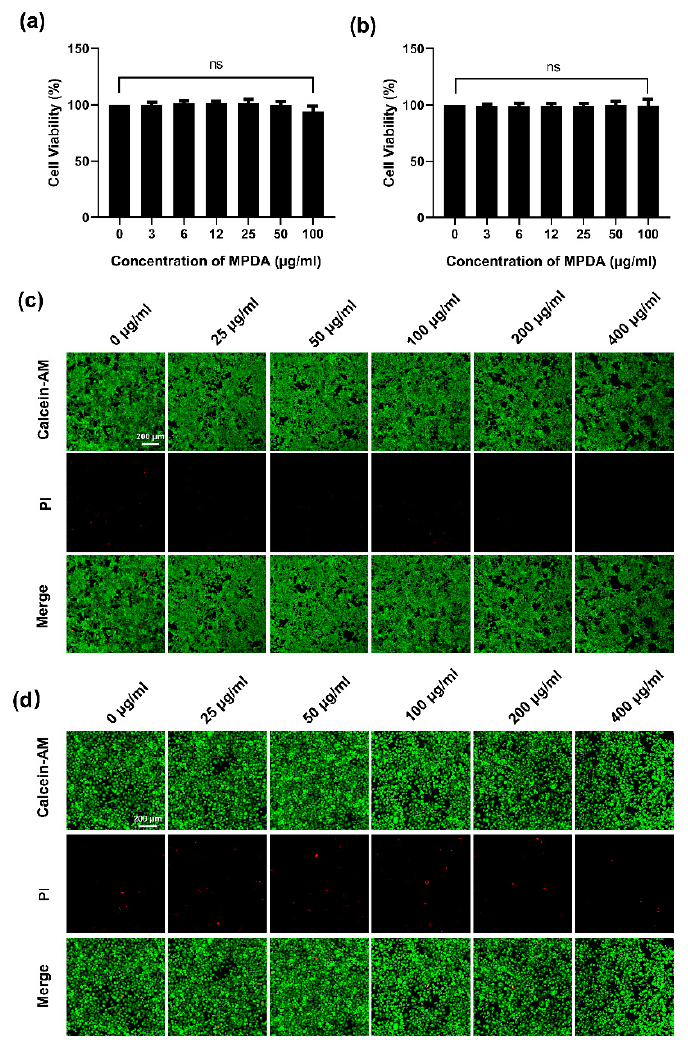
Figure 2. Effect of MPDA on cell viability. Comparison of different concentrations of MPDA in ( a ) HCT116 cells and ( b ) LO2 cells. Fluorescence images of ( c ) HCT116 and ( d ) LO2 after treating with different concentrations of MPDA for 24 h. Scale bar: 200 μ m.